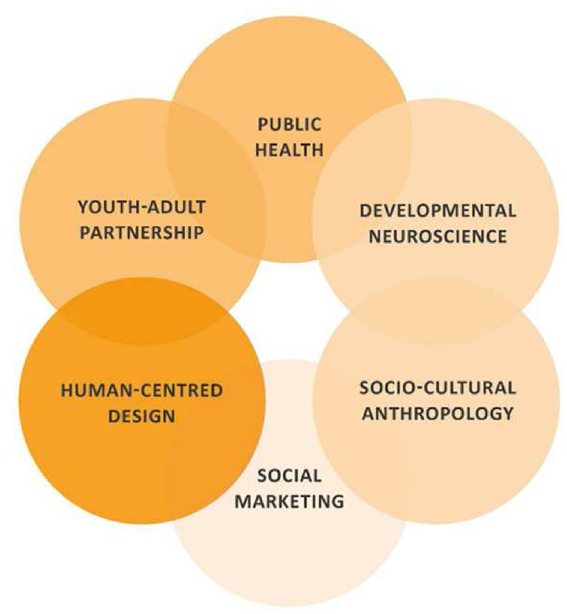
Figure 1. The A360